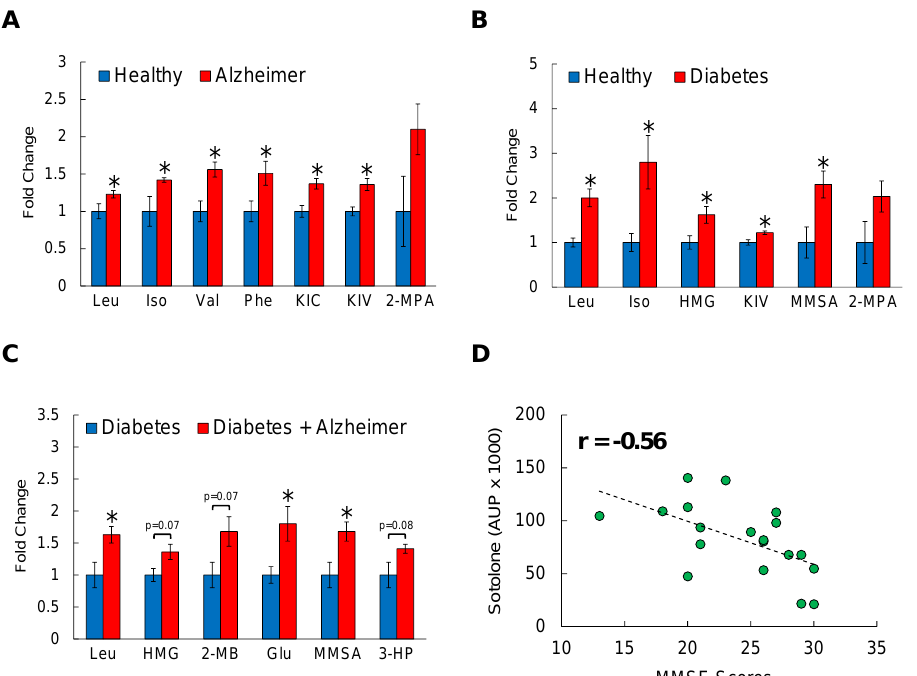
Figure 1. Circulating BCAA levels and their metabolites are elevated in individuals with AD. Serum samples from age- and BMI-matched healthy controls, patients with AD, T2D, or with T2D+AD after overnight fasting were analyzed by LC/MS. ( A ) Healthy vs. AD; ( B ) Healthy vs. Diabetes; ( C ) Diabetes vs. Diabetes+AD. Data shown are fold changes normalized to the mean of healthy or Diabetes controls; n = 10 males/group; mean age = 72 ± 3 years old; * p < 0.05. ( D ) Correlation analysis between serum sotolone, a metabolite of isoleucine, and MMSE scores. Iso: Isoleucine; HMG: 3-methylglutaryl (metabolite of leucine); KIV: ketoisovalerate (metabolite of valine); KIC: ketoisocaproate (metabolite of leucine); MMSA: Methyl-melonatesemialdehyde (metabolite of valine); Phe: Phenylalanine; 2-MPA: 2-methylpropanoic acid (metabolite of valine); 3-HP: 3-OH-Propanoate (metabolite of valine); MMSE: Mini-Mental State Examination.